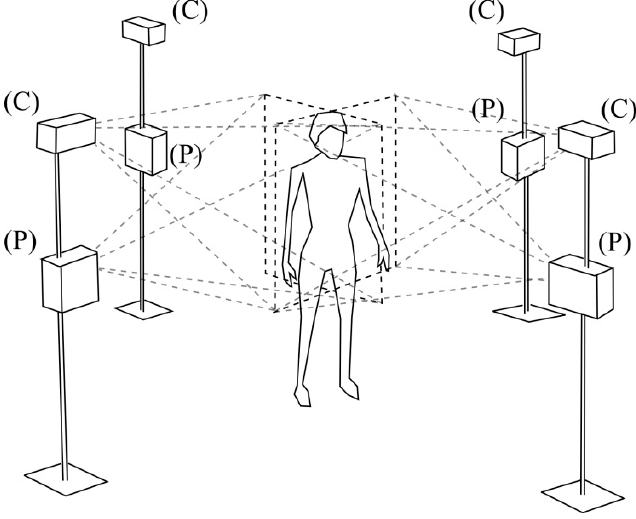
Figure 1. Four-directional optical measurement system scheme. C—camera, P—projector. Each scanner acquired information about a partial shape of a patient’s body, which was determined during the calibration process. The calibration enables directional data.